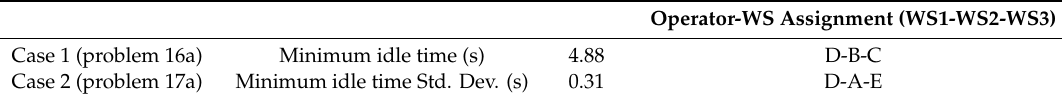
Table 10. Operator-WS assignments for T c = 15 s.